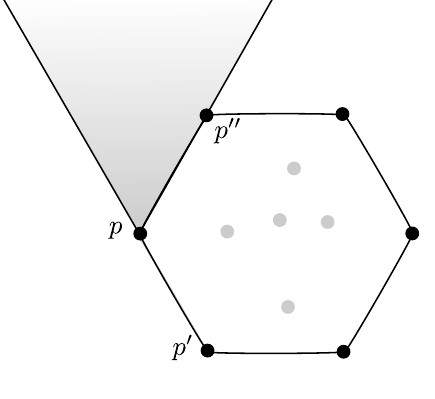
Fig. 2: The cone in the proof of Theorem